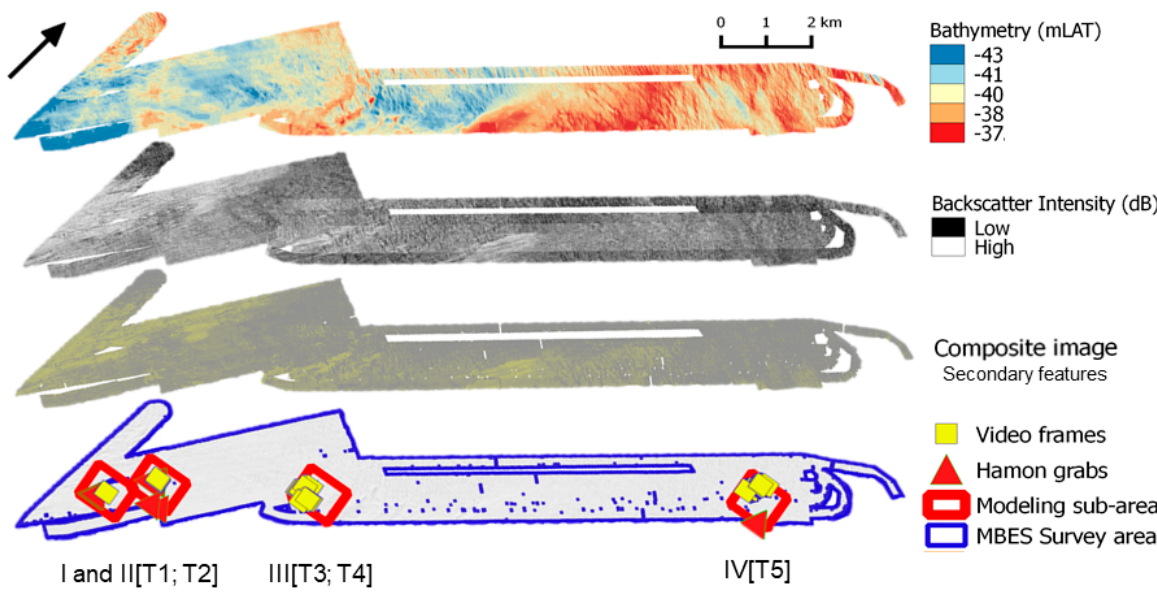
Figure 2. Overview of the MBES and ground truth surveys. Top to bottom: MBES bathymetry; compensated backscatter imagery; composite image of secondary features derived from the MBES primary data (see after, section “Spatial modelling by RF”); survey extent with ground truth locations and areas of interest selected for modelling. Areas of interest selected for modelling (Roman characters) and corresponding video transects (e.g., T1) are labelled accordingly in Figure 5 (see “Results” section).